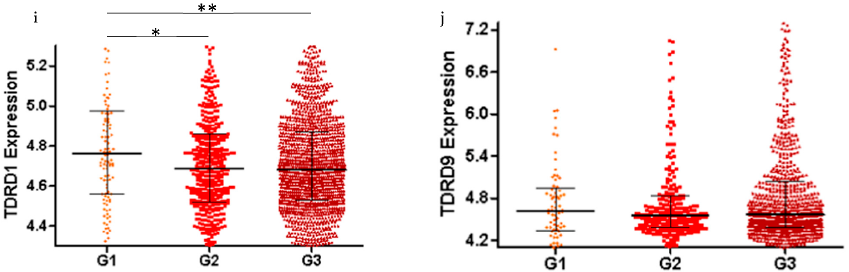
Figure 3. Using the CSIOVDB public microarray database ( n = 3431) to determine piRNA pathway gene expression in grades 1, 2 and 3 (G1, G2 and G3) of all ovarian cancer subtypes. ( a – d ) Among the 4 PIWIL genes, PIWIL1 and PIWIL3 showed significantly lower expression in the high grade (G2/G3) disease as compared to low grade (G1). PIWIL2 and PIWIL4 had similar expression levels in G1, G2 and G3 ovarian cancer samples. ( e , g – j ) PLD6 and TDRD1 also had significantly decreased expression when comparing low grade to high grade. DDX4 , MAEL and TDRD9 had no significant difference in expression across G1, G2 and G3. ( f ) HENMT1 , in contrast, had significantly higher expression in G2 and G3 as compared to G1. Mann − Whitney U test was used to assess significance. * p < 0.05; ** p < 0.005; *** p < 0.0005; **** p < 0.0001.